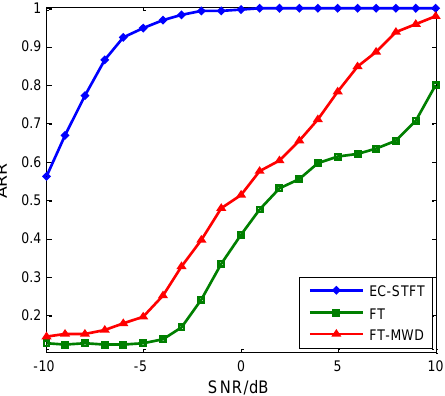
Figure 15. The comparison between EC-STFT and FT as feature selection